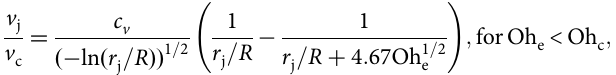
con fi guration (Fig. 6b, d) in this study, we revise Eq. (9) as (cid:2) a Oh b h h , with a and b as the numerical factors obtained e o